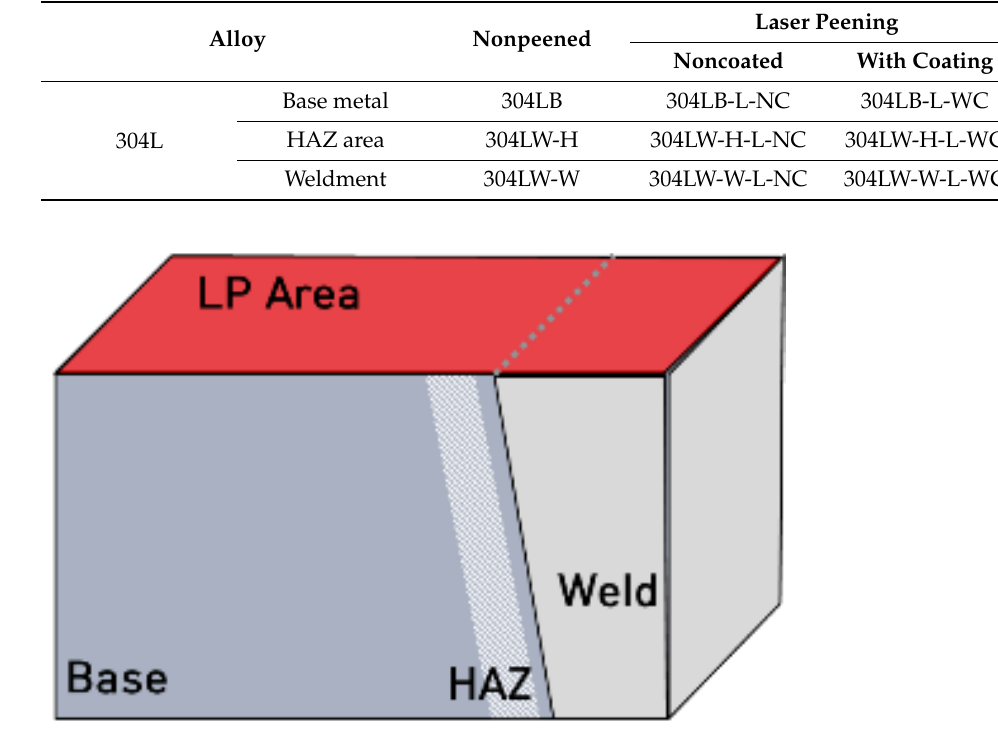
Figure 1. Schematic diagram of the base metal, HAZ, and welded metal specimens.